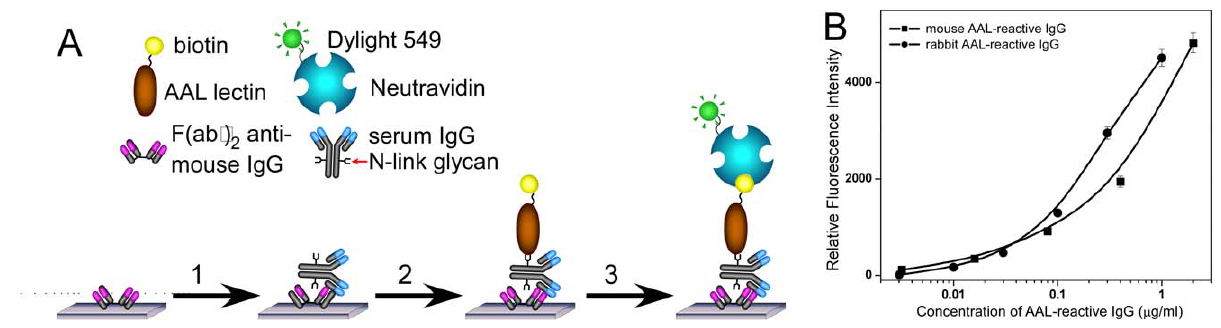
Figure 1. AAL-antibody microarray based AAL-reactive IgG detection assay. (A) A schematic drawing of the AAL-antibody microarray assay for the detection of mouse (or rabbit) AAL-reactive IgG: (1) mouse or rabbit serum samples were incubated on an antibody microarray; (2) AAL lectin was applied on the antibody microarray to detect glycans on the captured IgGs after unbound proteins were washed off; (3) Dylight 549 labeled NeutrAvidin was incubated on the microarray to detect the biotinylated AAL. (B) Representative mouse ( & ) and rabbit ( curves. The standard used for the curve was a completely denatured mouse IgG with known concentration. The capture F(ab 9 ) 2 was Goat F(ab 9 ) 2 fragment anti-mouse IgG for mouse IgGs, and Donkey F(ab 9 ) 2 fragment anti-rabbit IgG for rabbit IgGs, respectively. The relative fluorescence intensity of each data point was subtracted from the blank (PBS control), but were not shown in the curves due to the logarithm X-axis.